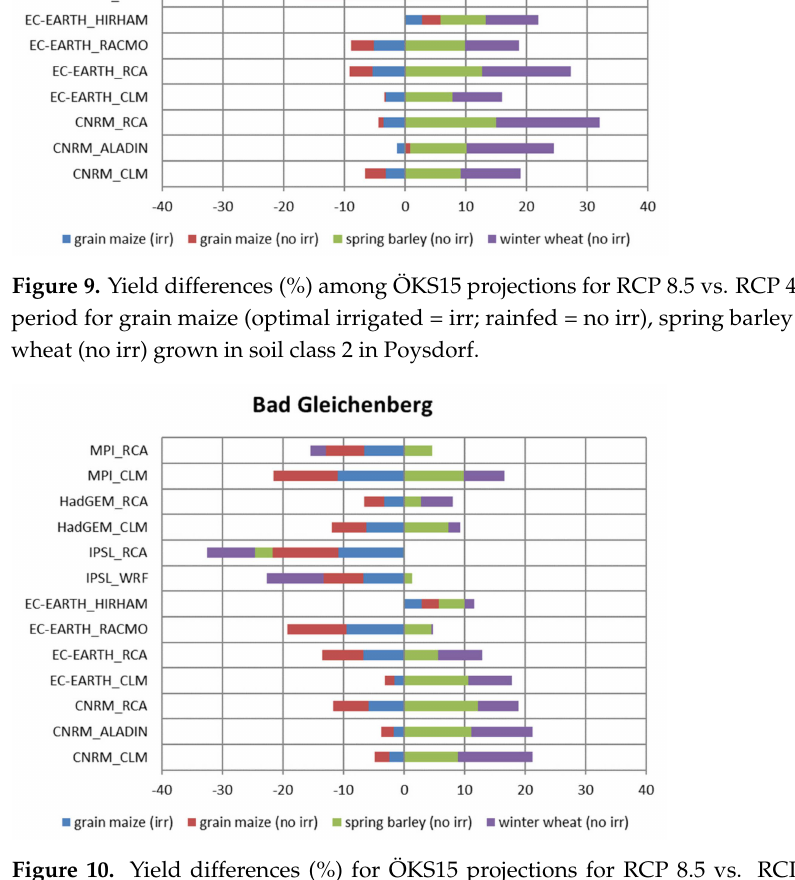
Figure 10. Yield differences (%) for ÖKS15 projections for RCP 8.5 vs. RCP 4.5 for the period 2071–2100 for grain maize (optimal irrigated = irr; rainfed = no irr), spring barley (no irr), and winter wheat (no irr) grown in soil class 2 in Bad